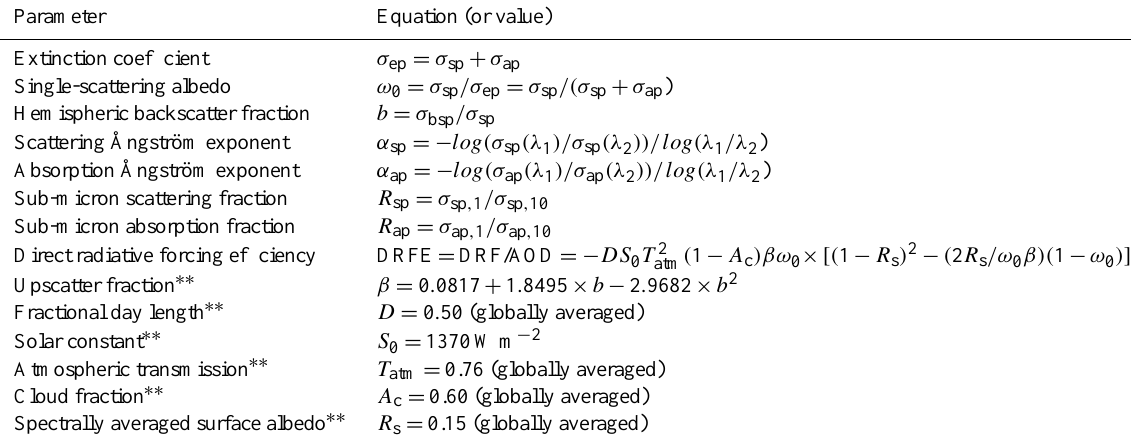
Table 2. Parameters and equations used to calculate aerosol optical properties. Constants and parameters used in the formula to calculate globally averaged top-of-atmosphere direct radiative forcing (DRFE) for each site are also included and are denoted with ∗∗